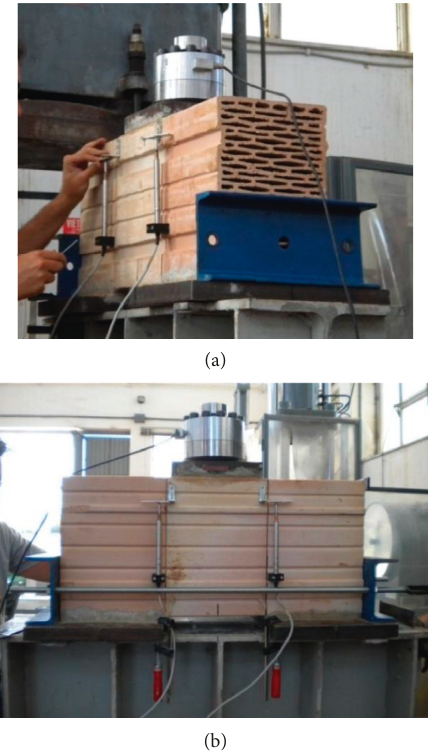
Figure 8: Details of the test setup: (a) positioning of the trans- ducers for measurements; (b) specimen ready for the test.